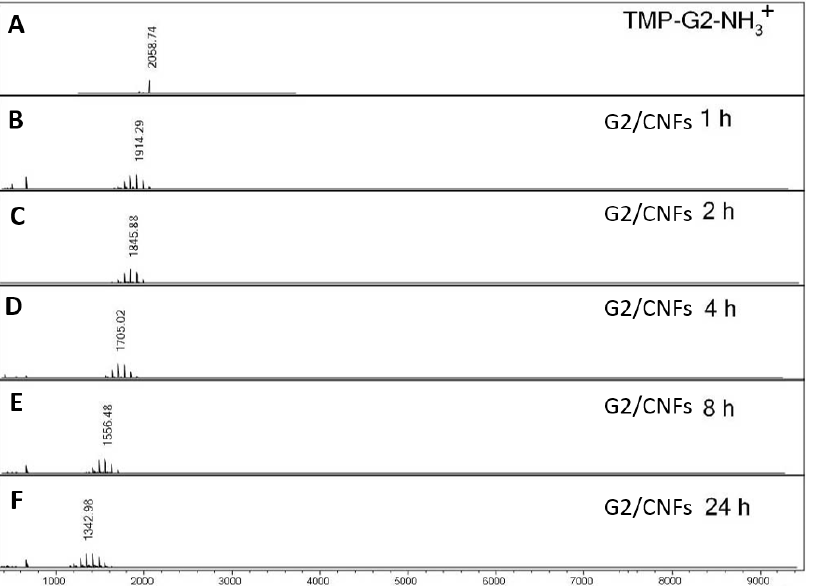
Figure 3. MALDI-TOF spectra of ( A ) pure G2 dendrimer, ( B ) leaching of G2 from the hydrogel after 1 h in phosphate-buffered saline (PBS), ( C ) leaching of G2 from the hydrogel after 2 h in PBS, ( D ) leaching of G2 from the hydrogel after 4 h in PBS, ( E ) leaching of G2 from the hydrogel after 8 h in PBS, ( F ) leaching of G2 from the hydrogel after 24 h in PBS at 37 °C.